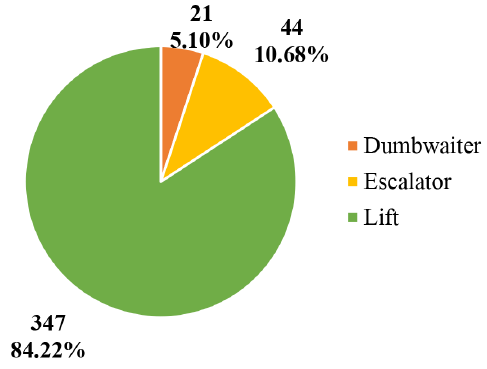
Fig. 2 Statistic of elevator types in the 412 accidents.